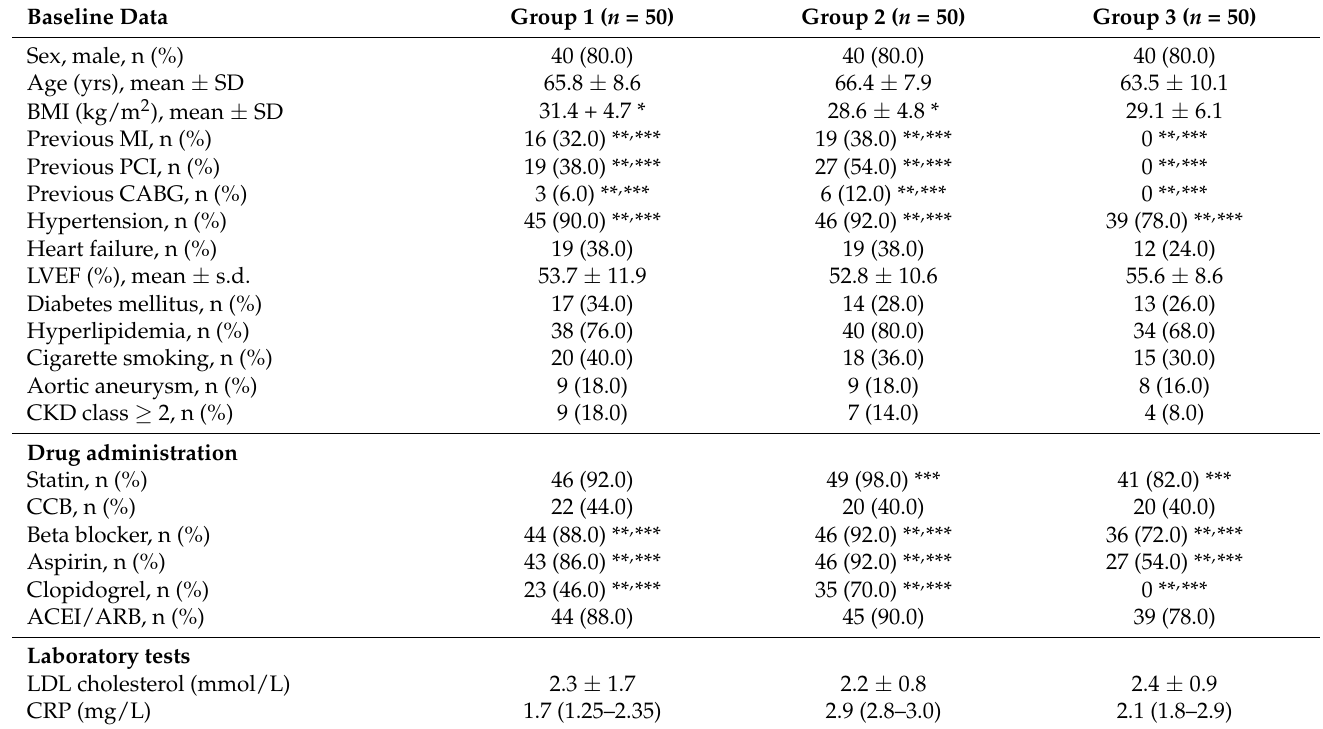
Table 1. Baseline clinical